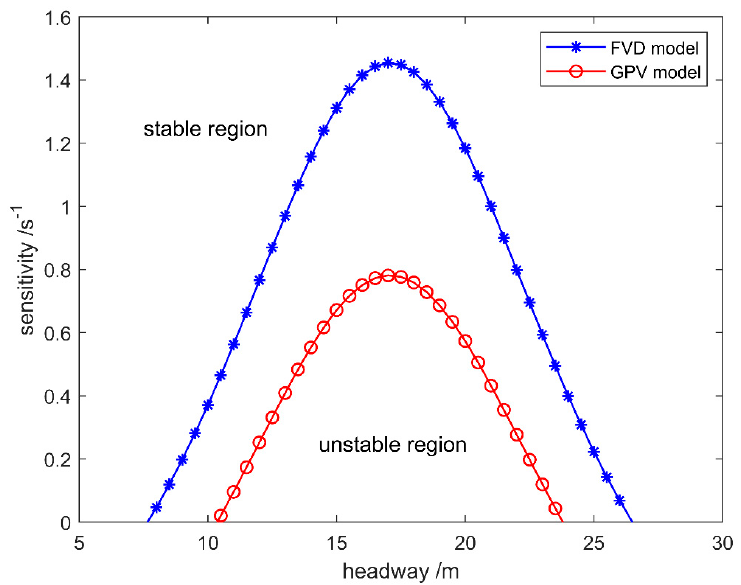
Figure 4. The neutral stability curves of the GPV model and the FVD model with calibrated parameters.